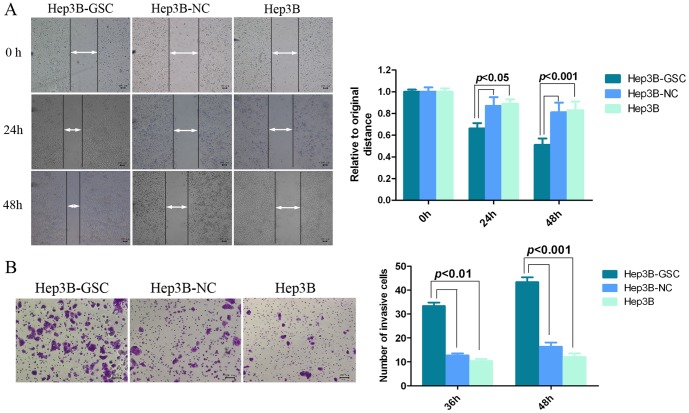
Effects of GSC overexpression on migration of HCC.Hep3B-GSC cells were infected by GSC lentivirus and were selected with puromycin. (A) Wound-healing assay shows that Hep3B-GSC cells migrated faster than normal Hep3B or Hep3B cells without treatment after 24 h and 48 h. The cleared area of Hep3B-GSC was less than the controls. (50× original magnification, size bar: 100 µm) Results were analyzed with the Student t test. (B) Giemsa staining indicated the number of Hep3B-GSC cells that migrated through Matrigel was higher than Hep3B cells without treatment or treated with negative control (100× original magnification, size bar: 100 µm). The data are presented as the mean ± SD of at least three independent experiments. Results were analyzed using Student's t test.